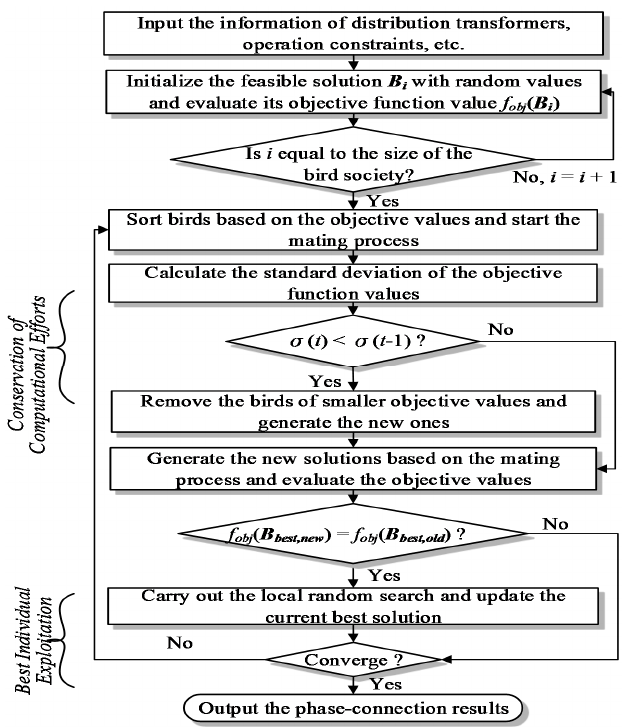
Figure 3. Flowchart of hybrid bird ‐ mating optimization approach.